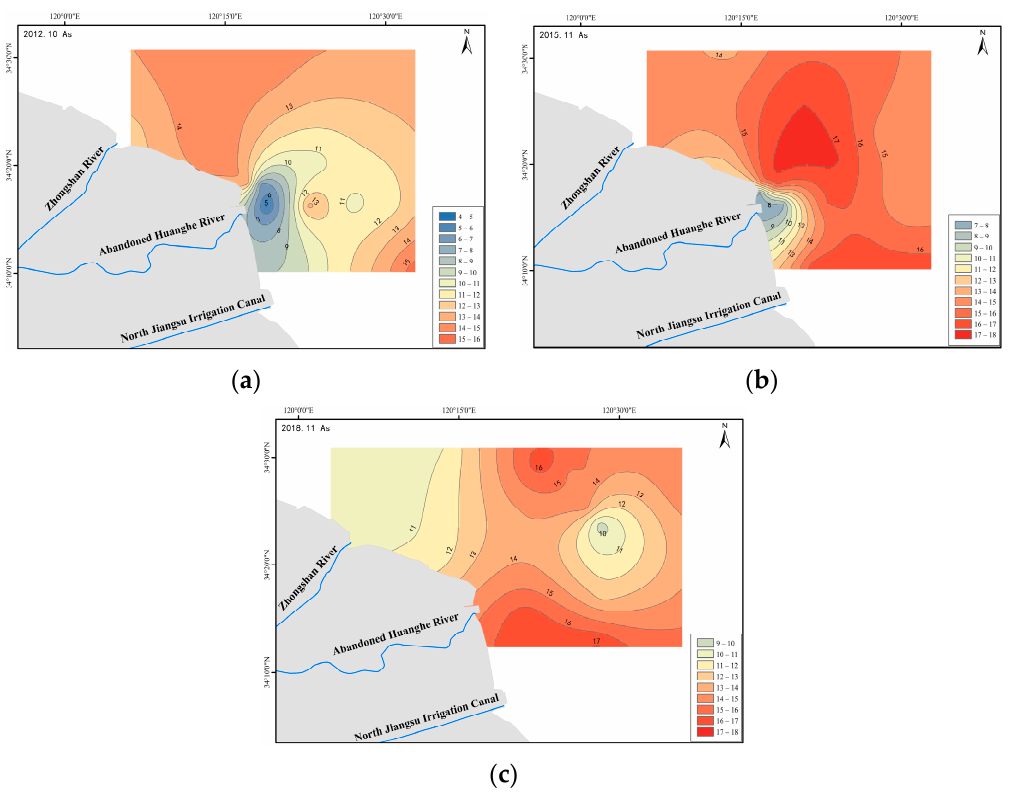
Figure 11. Spatial distribution of As in the sediments. ( a ) 2012; ( b ) 2015; ( c ) 2018.